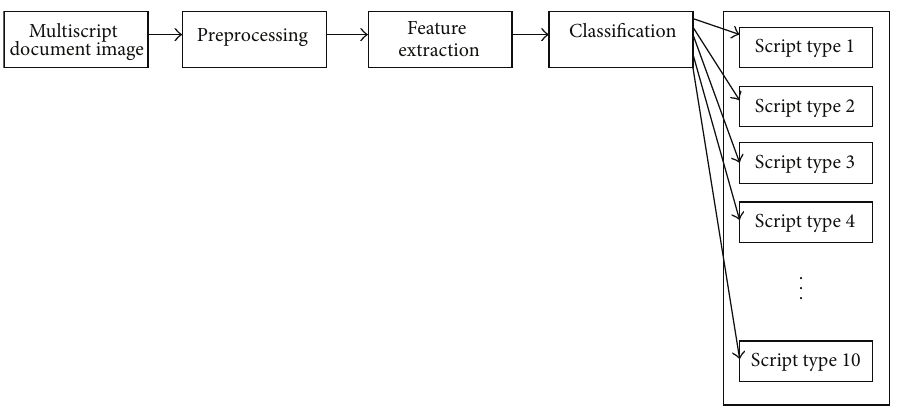
Figure 1: Block diagram of the present